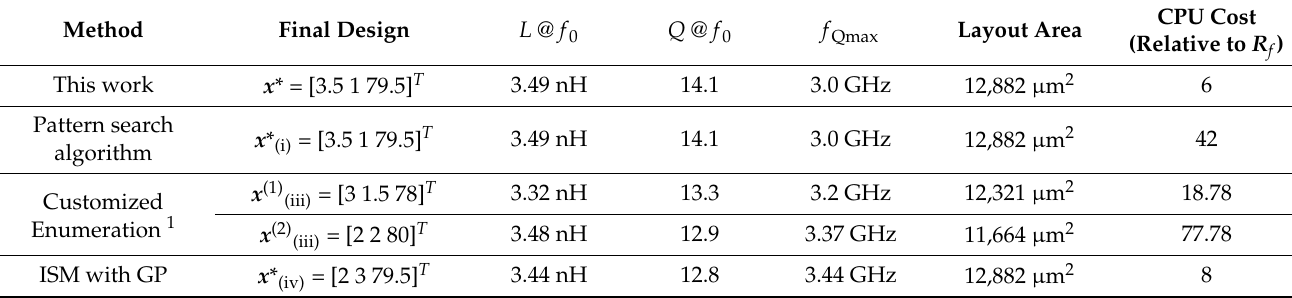
Table 7. Comparison of different optimization